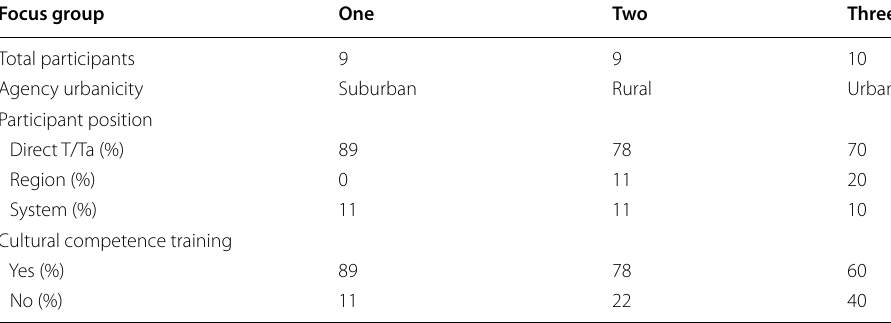
Table 1 Characteristics of the focus groups Focus